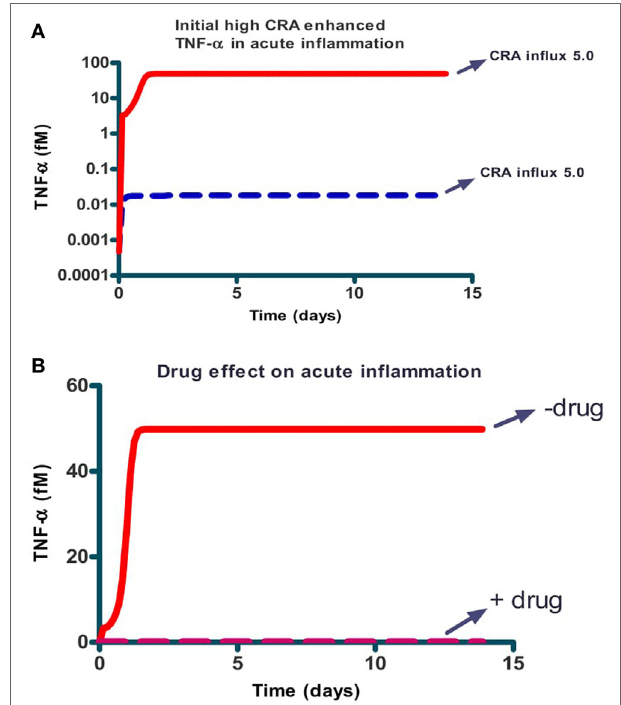
FigUre 6 | Prevention: the effect of a single dose of CRA on steady-state TNF- α level for the case of acute inflammation in the absence (a) and presence [ (B) dashed line] of a single dose of IgLC-binding peptide. (a) Simulations started at an acute inflammation steady state with 5.0 fM/min CRA influx (as in Figure 4a ) and a bolus of CRA was added at this time 0. The amounts added were 0.01 fM and 10 µM for the dashed blue and full red lines respectively. (B) 10 µM of CRA was added at time 0 together with (dashed red line) or without (full red line) 1.0 nM of peptide. CRA influx was maintained at 5.0 fM/min in all